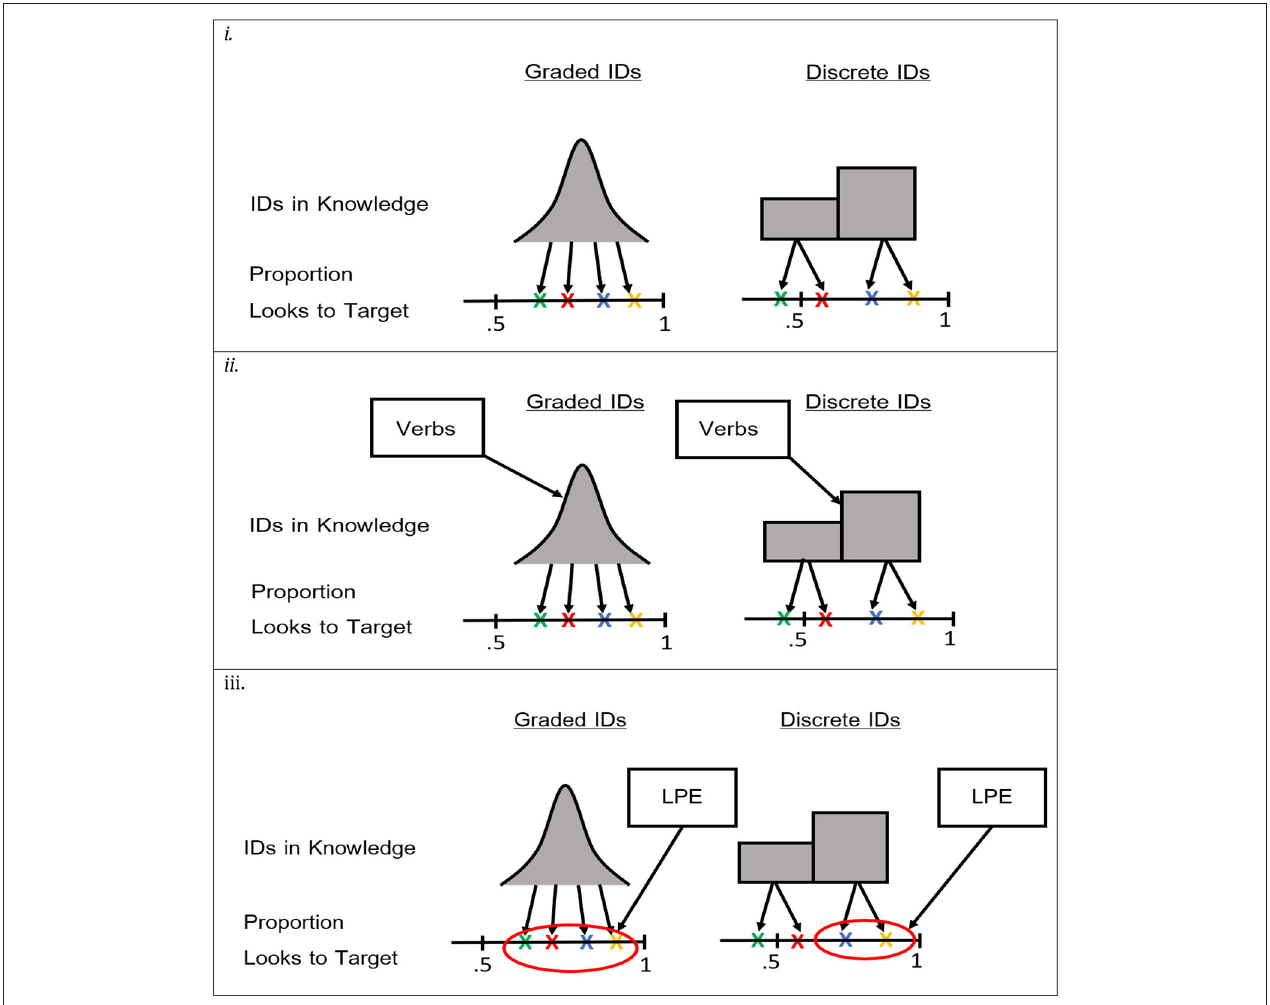
FIGURE 1 | Depictions of the models testing predictions about the structure and source of individual differences. Xs represent hypothetical data points (proportion of looks to target) for different participants. Pane (i) represents models testing the structure of individual differences. Pane (ii) represents models testing the effects of the number of verbs known. Pane (iii) represents models testing the effect of lexical processing